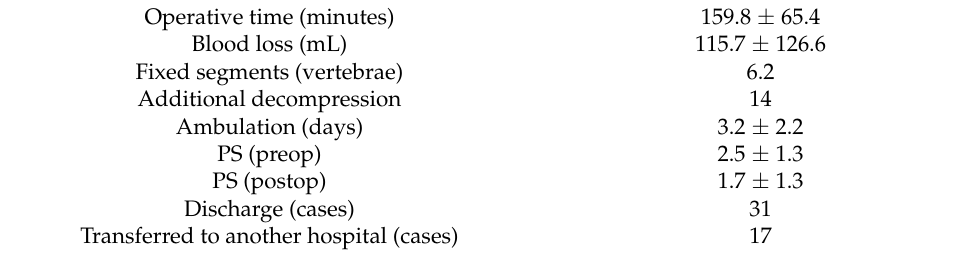
Table 2. Details of the surgery.